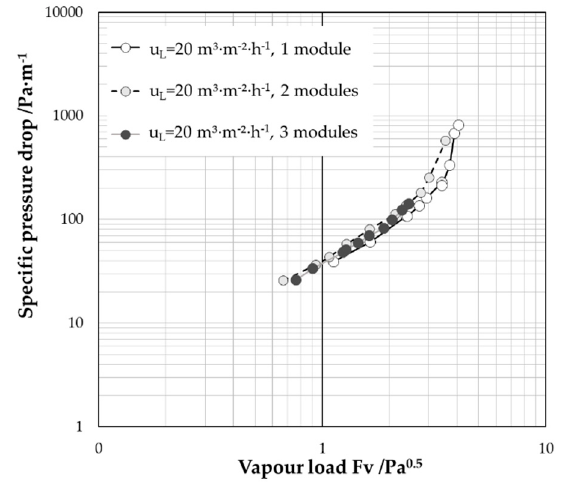
Figure 4. Specific pressure drop as a function of F-Factor for varying number of modules and a liquid load of u L = 20° m³ ∙ m − 2 ∙ h − 1 [86].